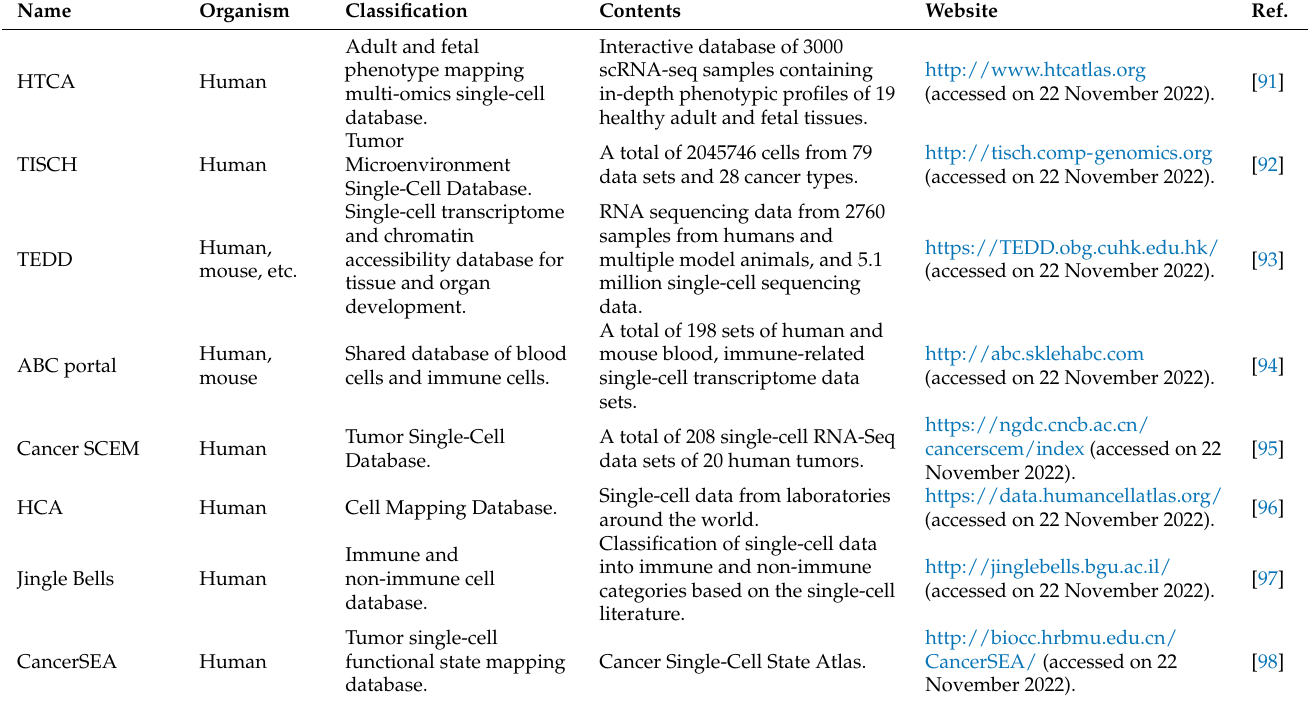
Table 9. Common databases for single-cell sequencing